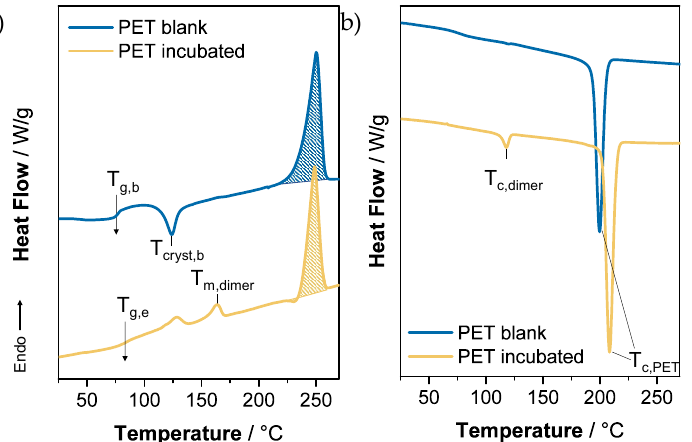
Figure 6. DSC thermograms of the first heating run ( a ) and first cooling run ( b ) for PET blank (blue) and PET incubated with PETase (orange). For the enzyme-treated samples, the rise of a second melting peak was identified as BHET dimer.